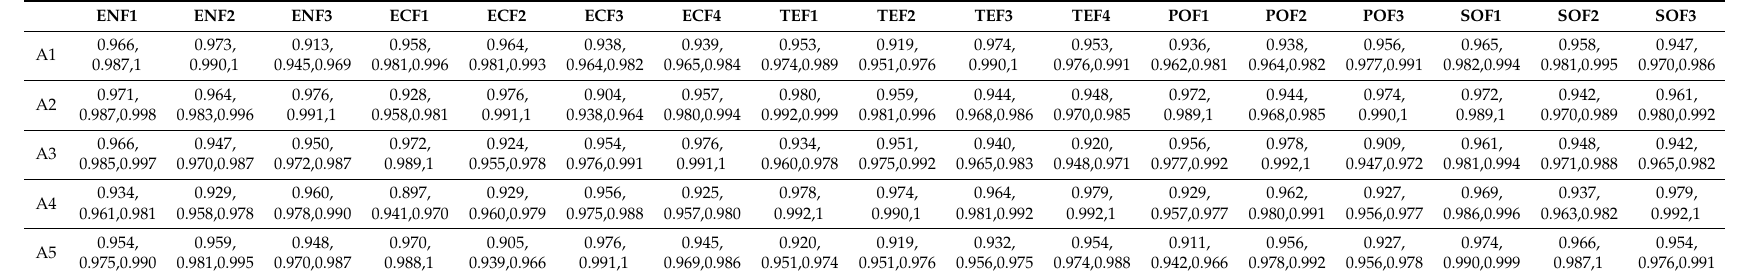
Table A12. Fuzzy weighted normalized matrix for